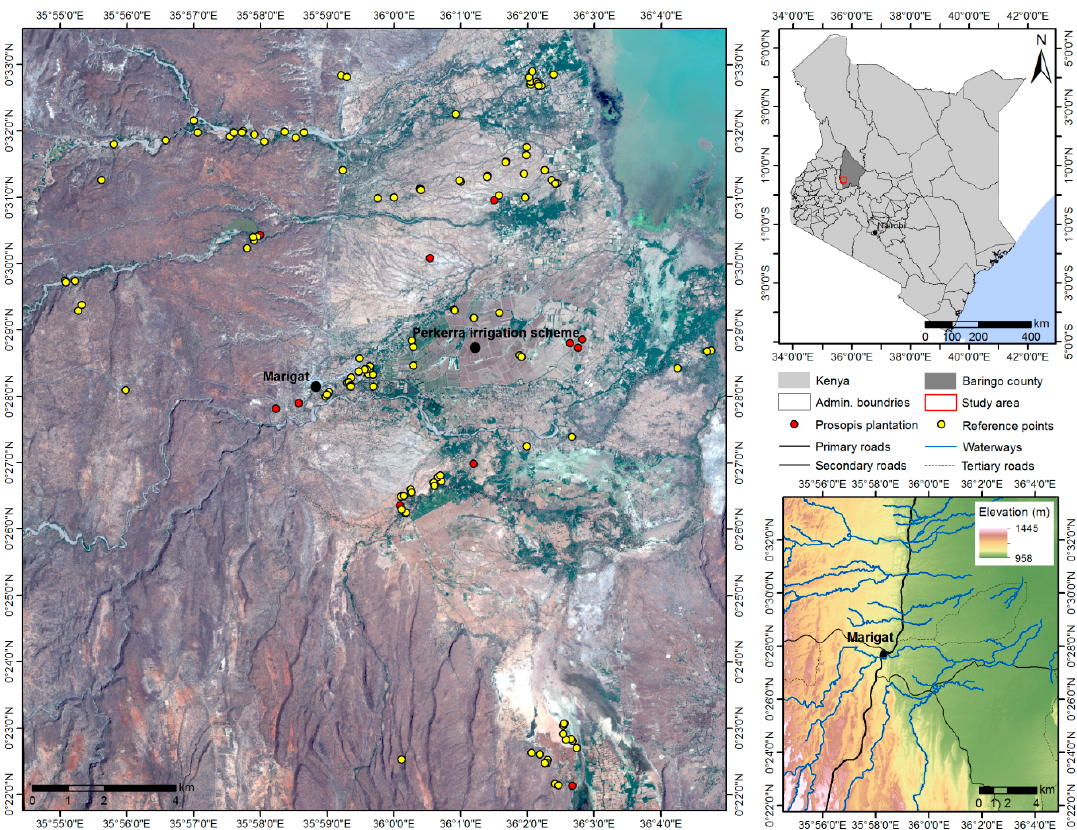
Figure 2. Pan-sharpened true color Pléiades image (using subtractive resolution merge in Erdas Imagine [46]) of the study area centered around Marigat ( left ), including the Prosopis plantations [10] and in situ collected reference dataset used for training the classifier. Map of Kenya ( upper right ) with location of ROI and Digital Elevation Model ( lower right ) generated from Pléiades stereo imagery along with roads and waterways.